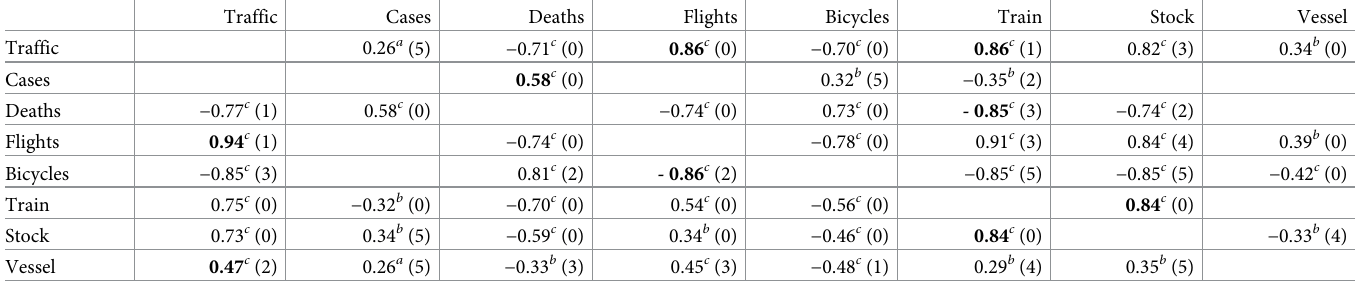
Table 1. Original time-series (lag = 0) on rows and lagged variable on columns. The diagonal, as well as correlations that are not significant ( p > 0.05) are omitted from the table. We present each correlation along with the best lag for the column variable (round brackets) and its significance level: a ( p < 0.05), b ( p < 0.01), c ( p < 0.001) (superscript).